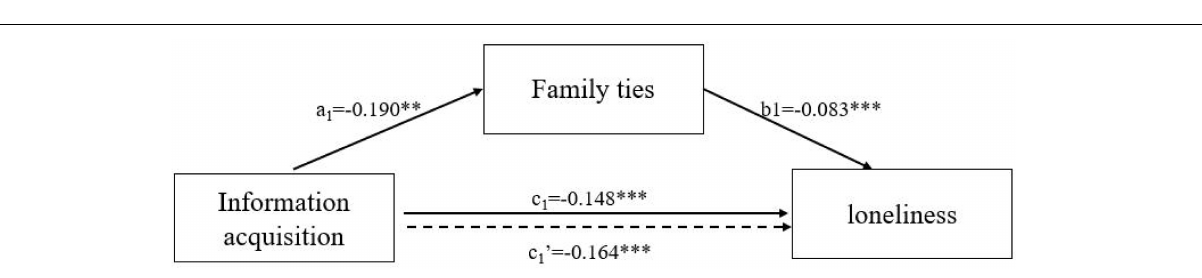
FIGURE 2 | The suppressing effects of family ties in the association between information acquisition and loneliness. *** p < 0.001, ** p < 0.01, * p <